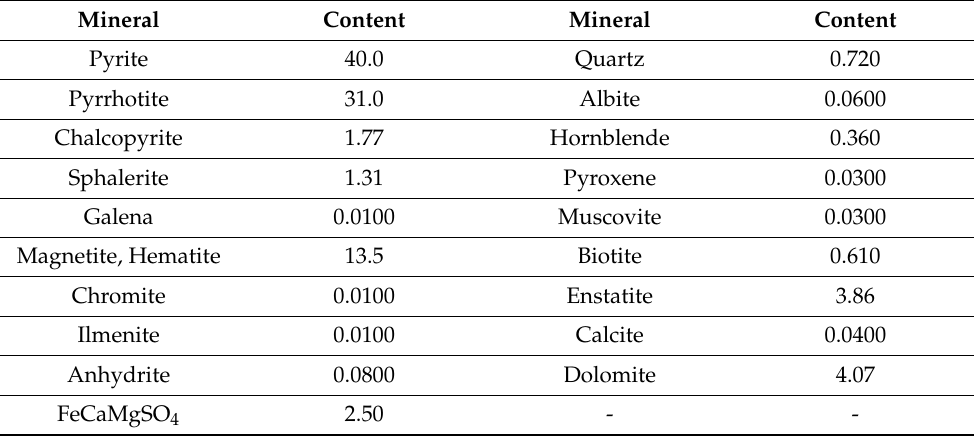
Table 4. MLA results for main mineral constituents in sulfide concentrate